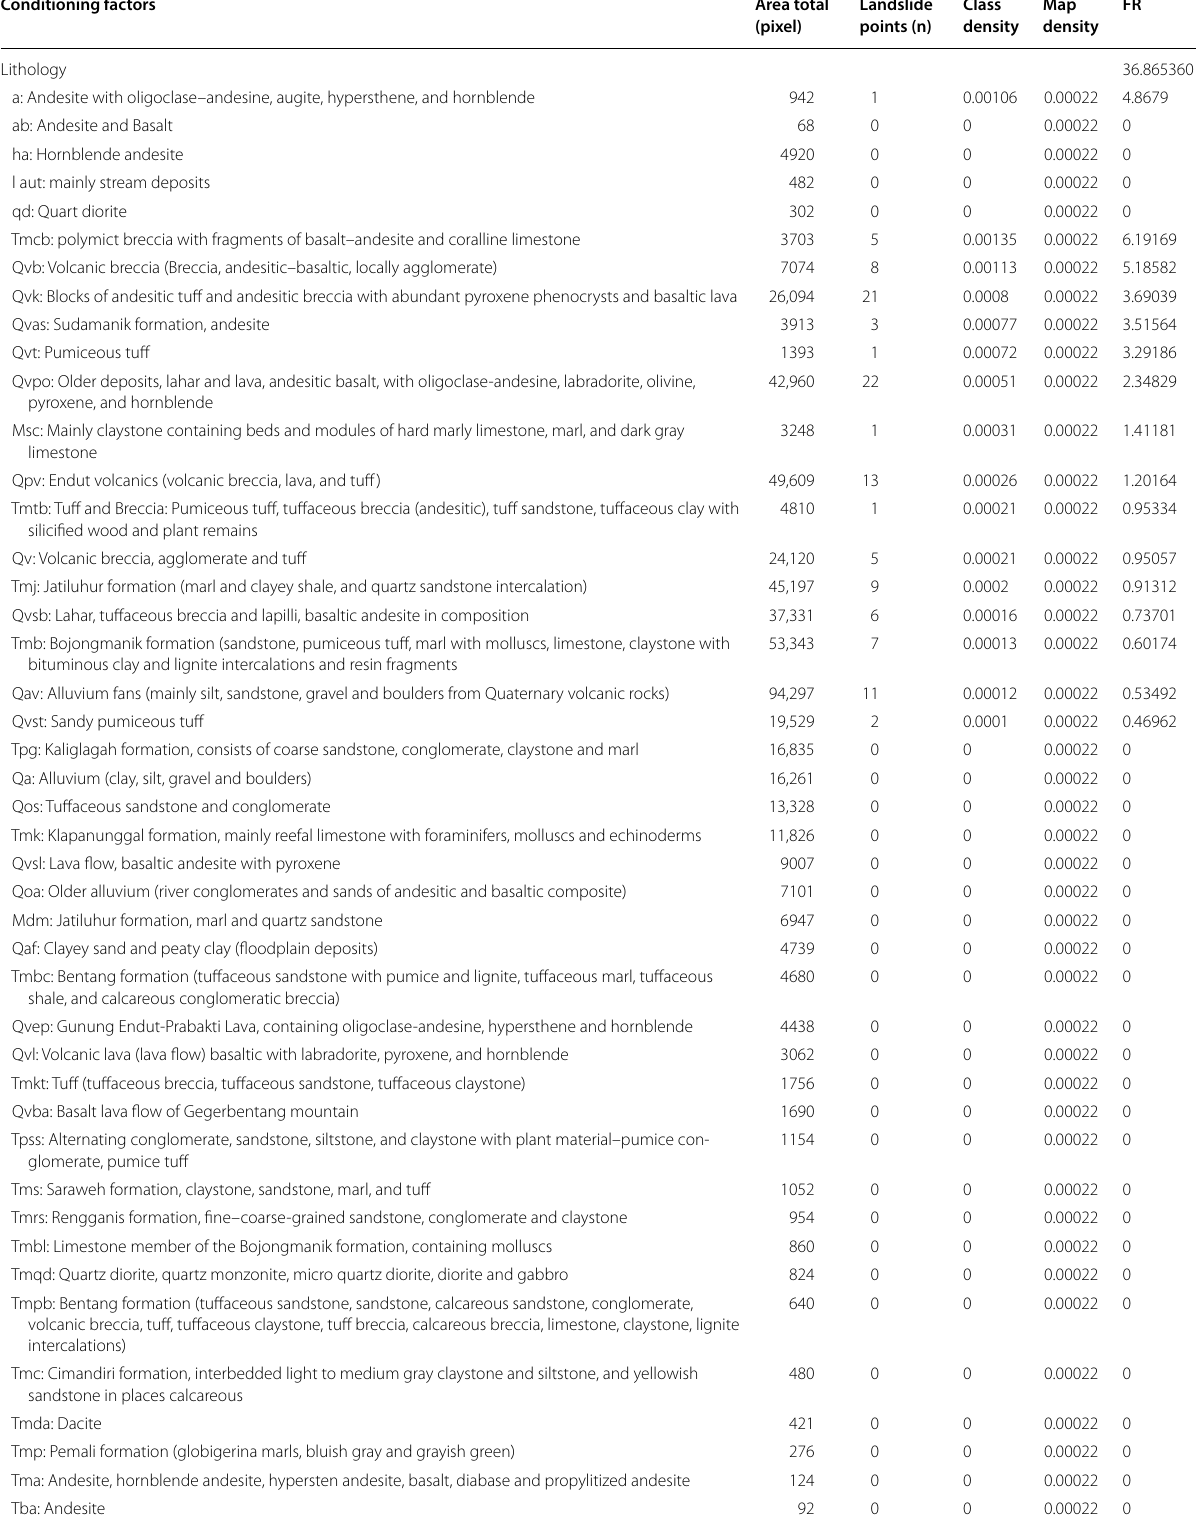
Table 3 Frequency ratio values for conditioning